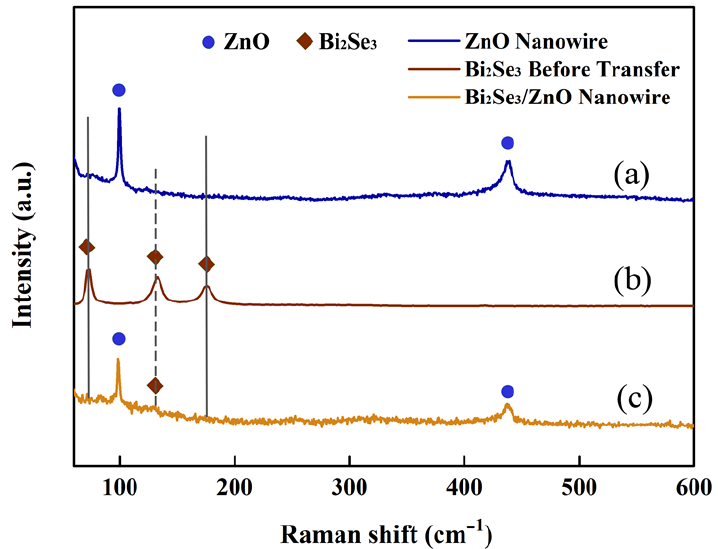
Figure 2. Raman curves of ( a ) ZnO NWAs, ( b ) 2D Bi 2 Se 3 and ( c ) Bi 2 Se 3 /ZnO